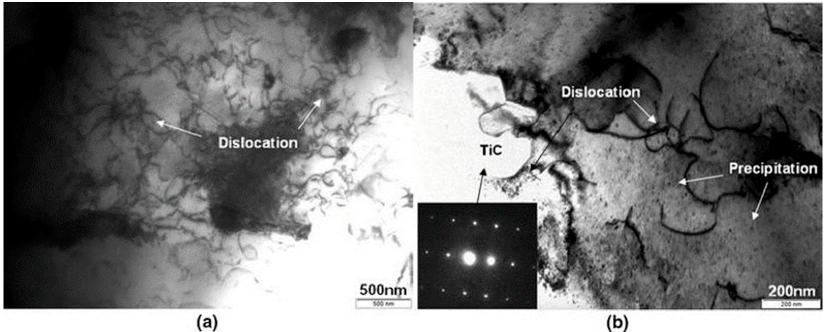
Figure 13. TEM micrographs of LENS-deposited IN625 TiC/Ni MMCs: ( a ) high density of dislocation in matrix and ( b ) large amount of precipitation interacting with dislocations [11].